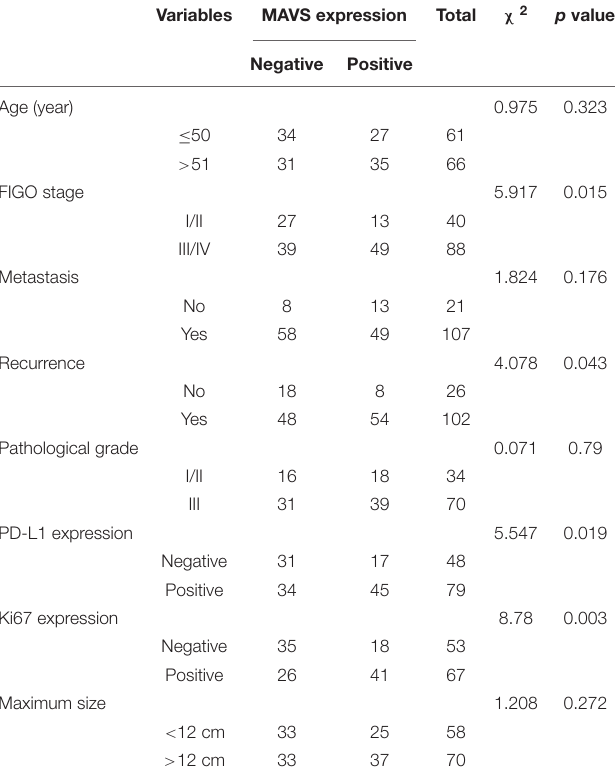
TABLE 1 | Correlation between MAVS expression and clinicopathological characteristics of OC patients. Variables